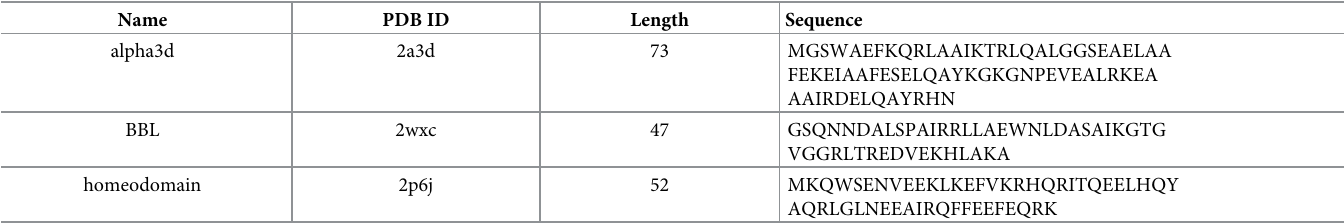
Table 2. Sequences of proteins for molecular dynamics